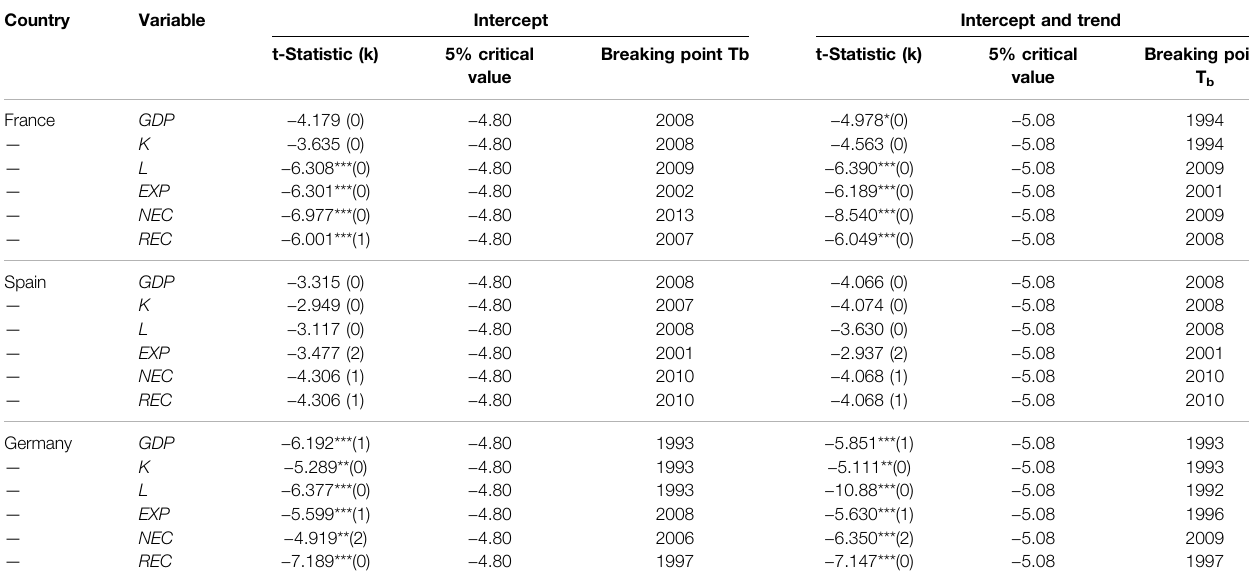
TABLE 7 | results of the Zivot-Andrews (ZA) unit root test with structural breaks.